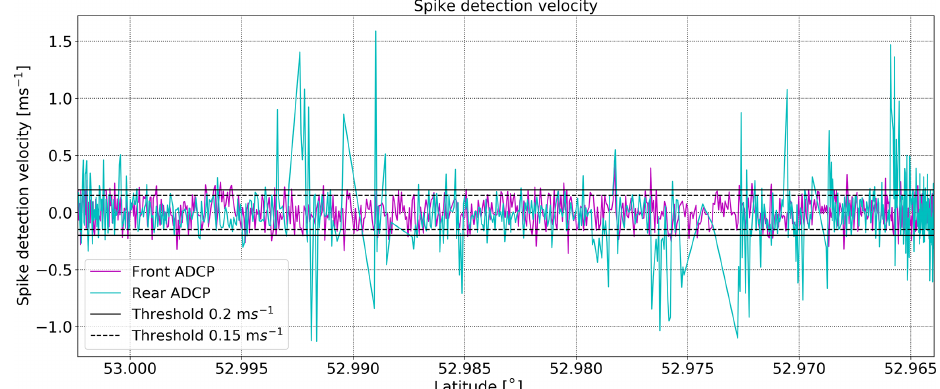
Figure 3. Example of spike detection velocity compared to QA thresholds; second bin below the vessel, 7 April 2021, 06:00